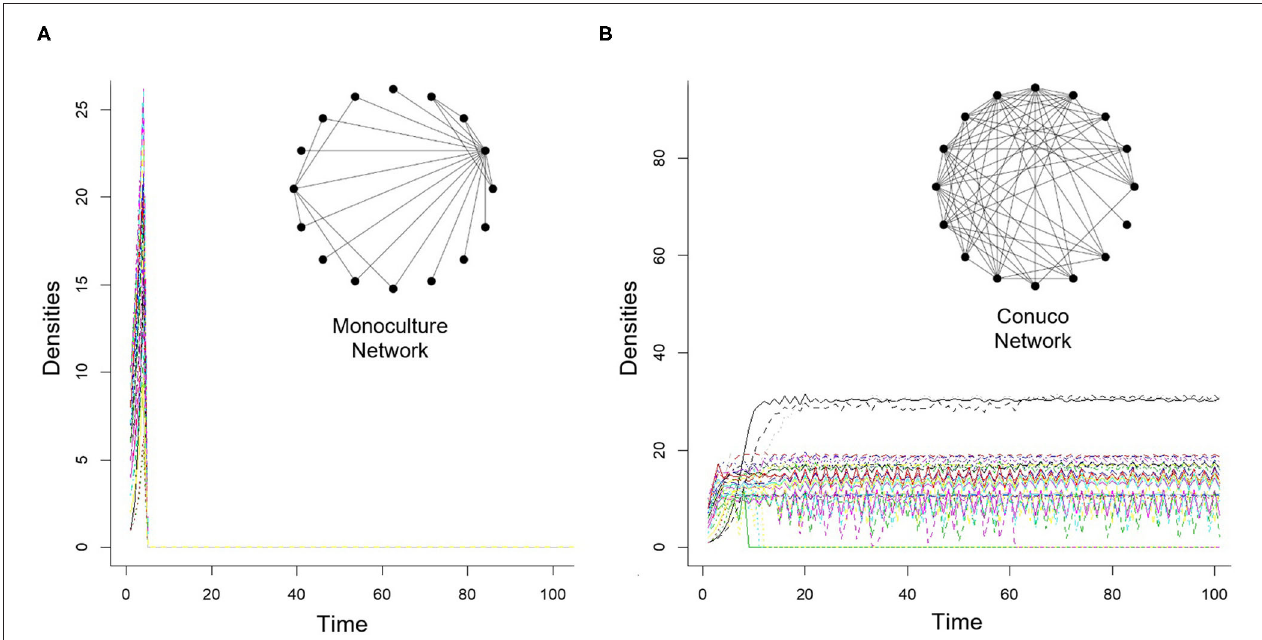
FIGURE 3 | Characteristic population dynamics associated with the topologies of Monoculture (A) and Conuco (B) . Each color line represents the density of a different species (modified from Griffon and Hernandez, 2014; Griffon and Rodríguez,